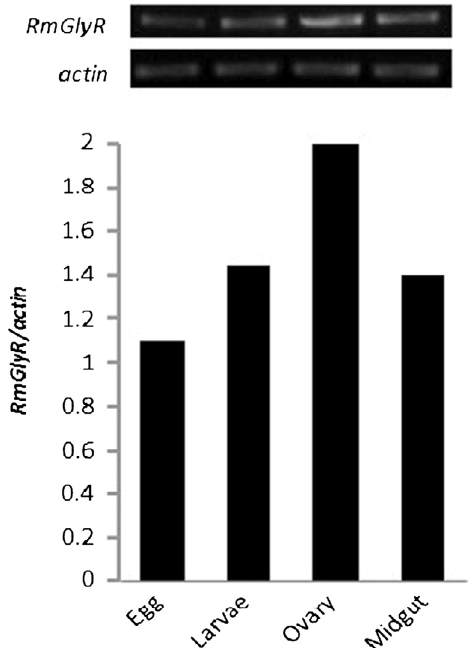
Figure 4. Expression of the RmGlyR gene in different stages of R. microplus . RT-PCR reactions were performed using total RNA from egg, larvae and adult tissues (ovary and midgut). Tick actin gene was used as a control. The data are expressed as a density ratio between RmGlyR and actin